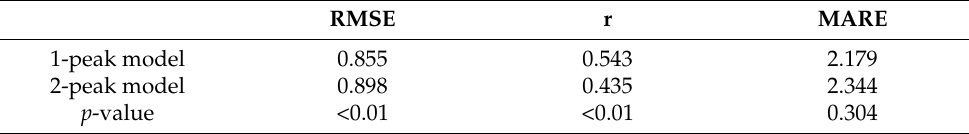
Table 2. Performance of the theoretical models for piglet activity.